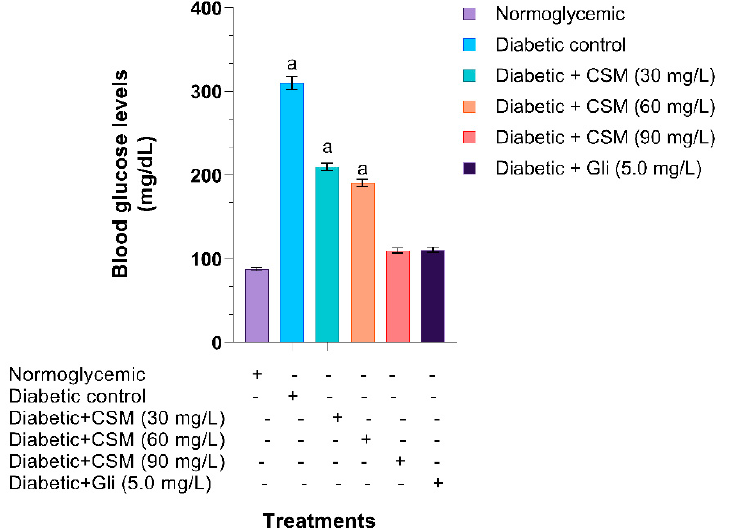
Figure 6. Effect of CSM on blood glucose levels of glucose-induced diabetic zebrafish. Each value represents the mean ± SE. a p ≤ 0.05 when compared to normoglycemic control group. The letter indicate significant differences between the different treatments. CSM; methanol extract from the seed of S. purpurea , Gli; glibenclamide.